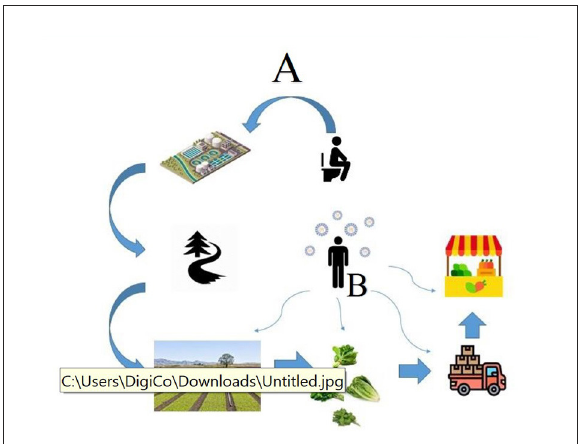
FIGURE1 The possible routes of transmission of the SARS-CoV-2 RNA from an infected person to agricultural products. Route A indicates the possible way of contamination in the pre-harvest stages. Route B indicates the possible ways of contamination by food handlers in the post-harvest